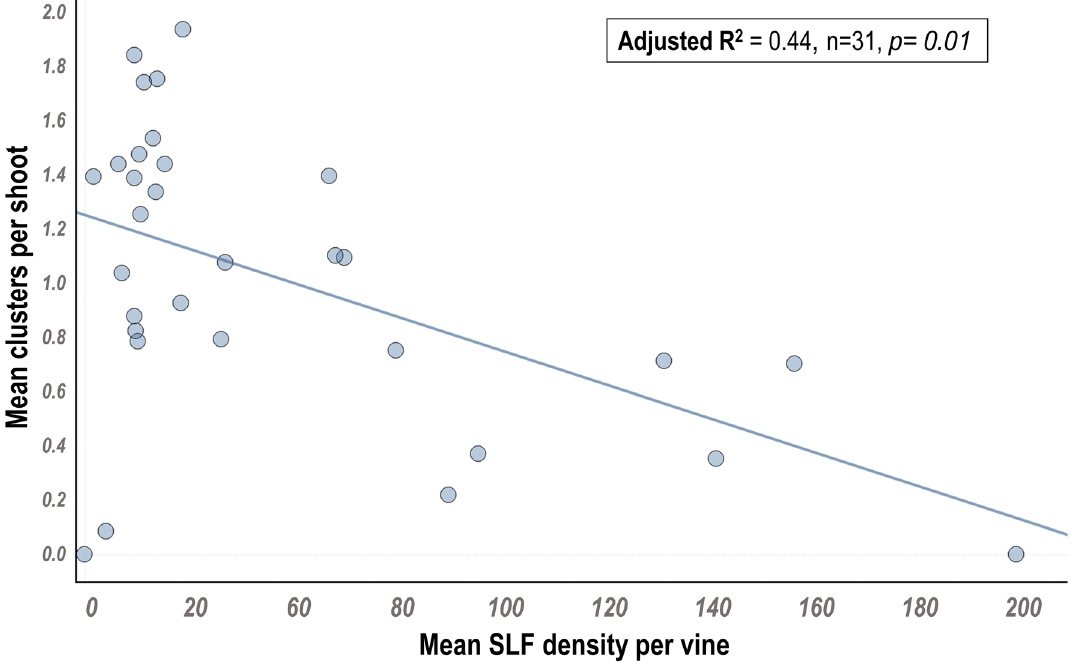
Figure 3. Relationship between mean spotted lanternfly (SLF) density per vine and grape cluster production (clusters per shoot/vine). Each point represents a single vine that was scouted for the SLF during the growing season. Cluster production on each vine was taken in the subsequent